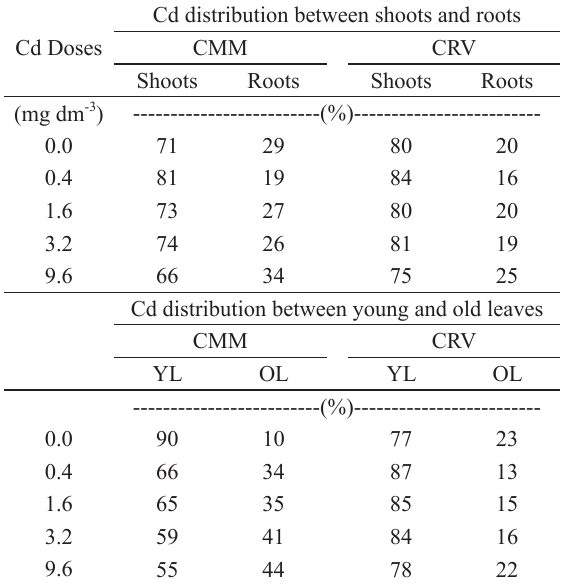
Cadmium distribution between shoots and roots and between young and old leaves in lettuce cultivars CMM and CRV, 44 days after seedlings transplanting to soil treated with